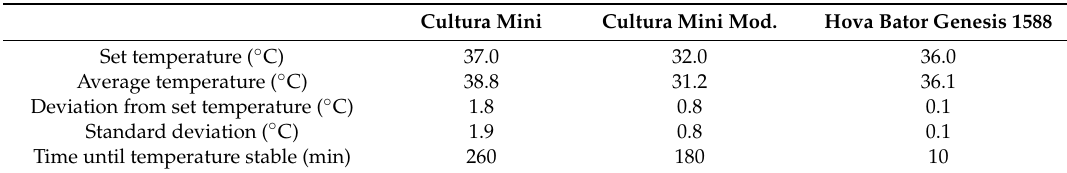
Table 2. Temperature comparison of different tested